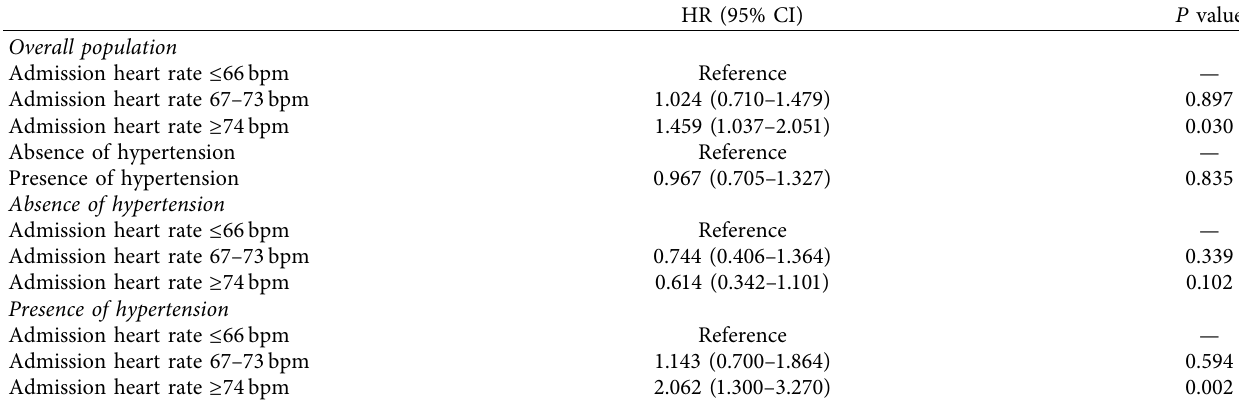
Table 3: Multivariate Cox proportional hazards analyses for MACEs according to the presence or absence of hypertension.